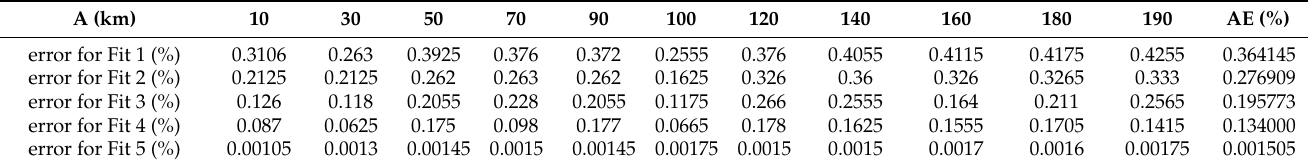
Table 12. LLL fault prediction error.